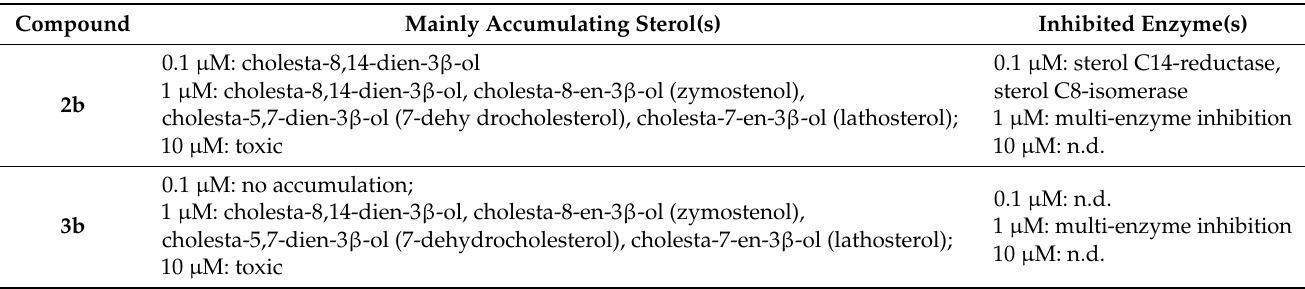
Table 5. Identification of the target enzyme(s) of compounds 2b and 3b in cholesterol biosynthesis on HL-60 cells. Mainly accumulating sterols under incubation and identified target enzymes. (), trivial name; n.d., not determined [35]. Compound Mainly Accumulating Sterol(s) Inhibited Enzyme(s)